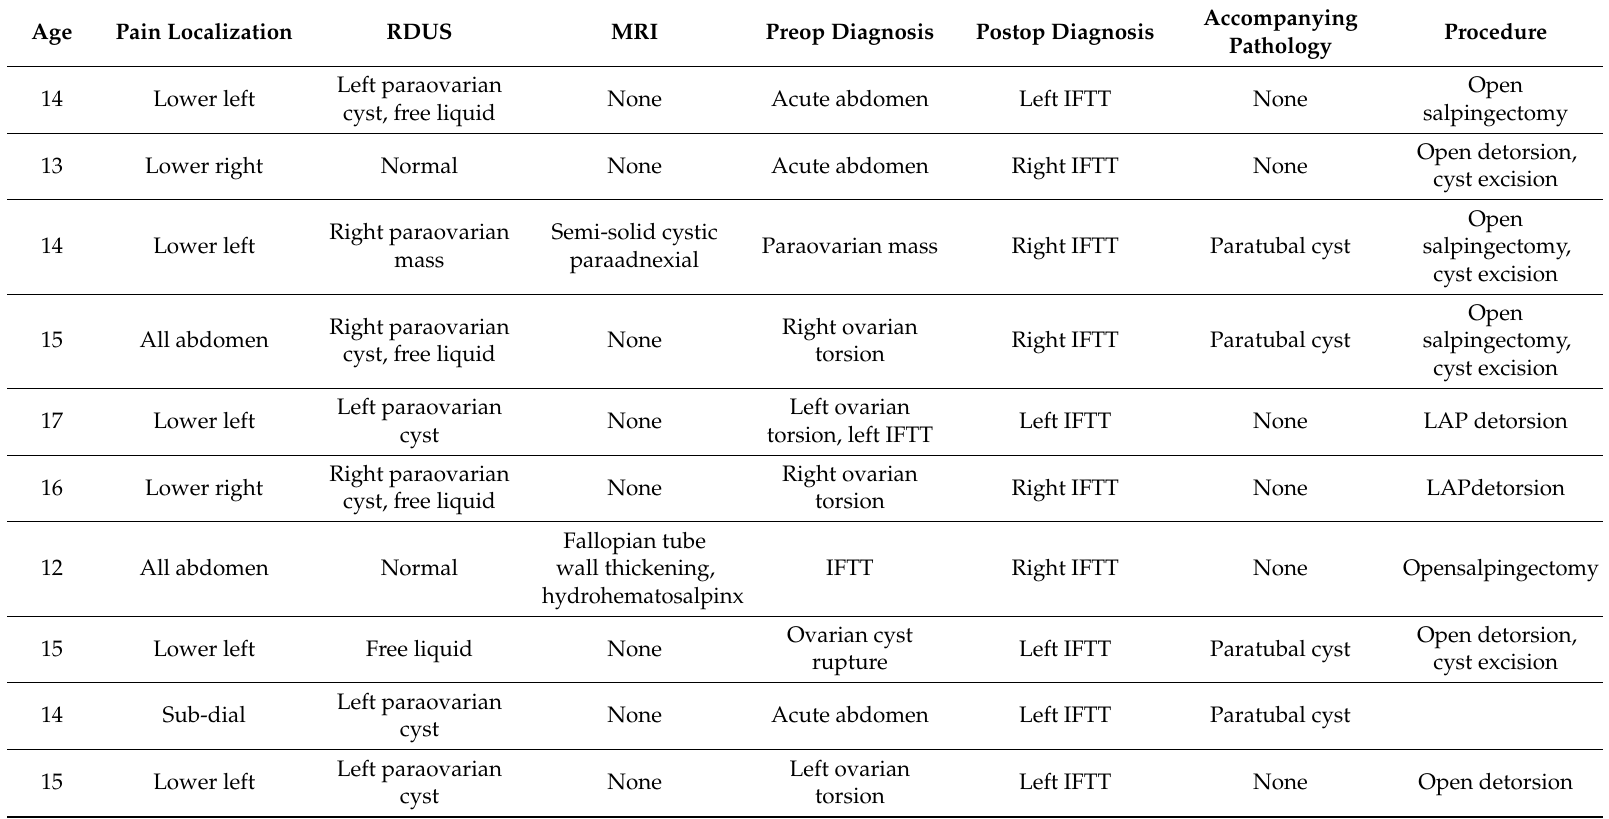
Table 2. Characteristics of fallopian tube torsion